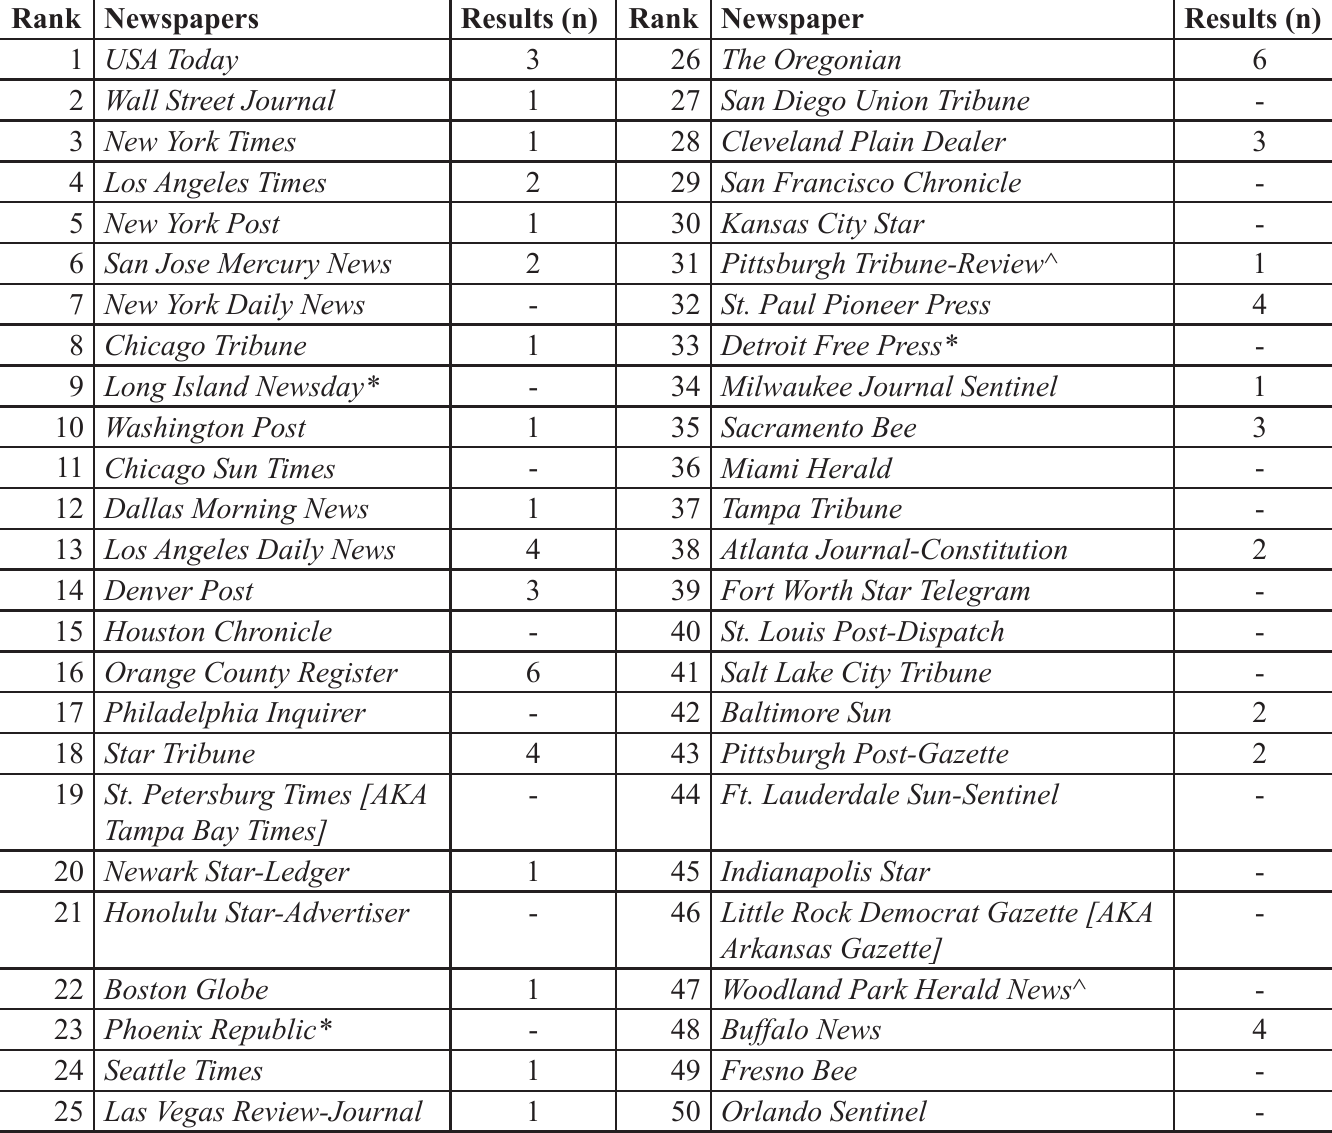
Table 1. Number of documents mentioning “health impact assessment” in the top 50 most circulated newspapers of 2014 published between 1990 and January 31, 2017 Rank